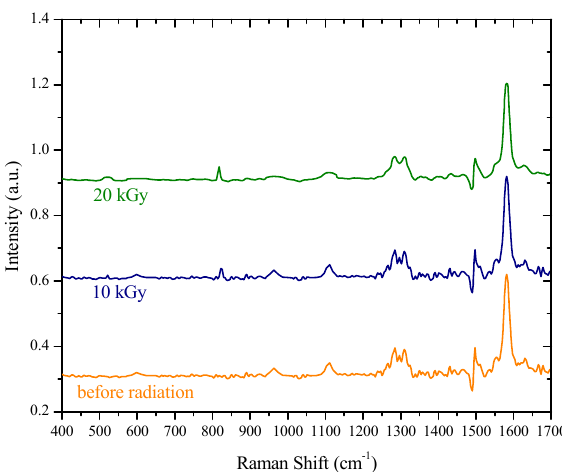
Figure 8. Raman spectra of the samples pre- and post-irradiation of MEH–PPV at a concentration of 20 μ M.